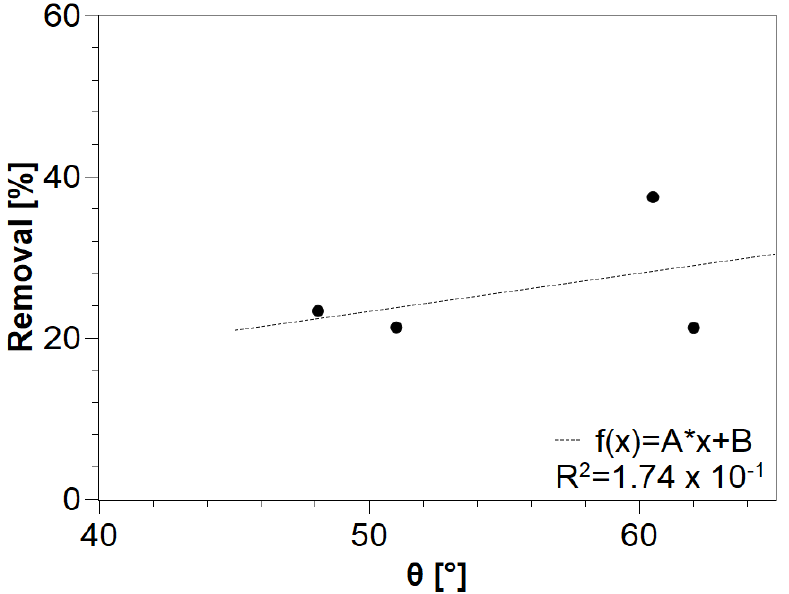
Figure 6. Correlation between removal rates and contact angles of surfactant solutions (1 g/L) on a flat PET surface.